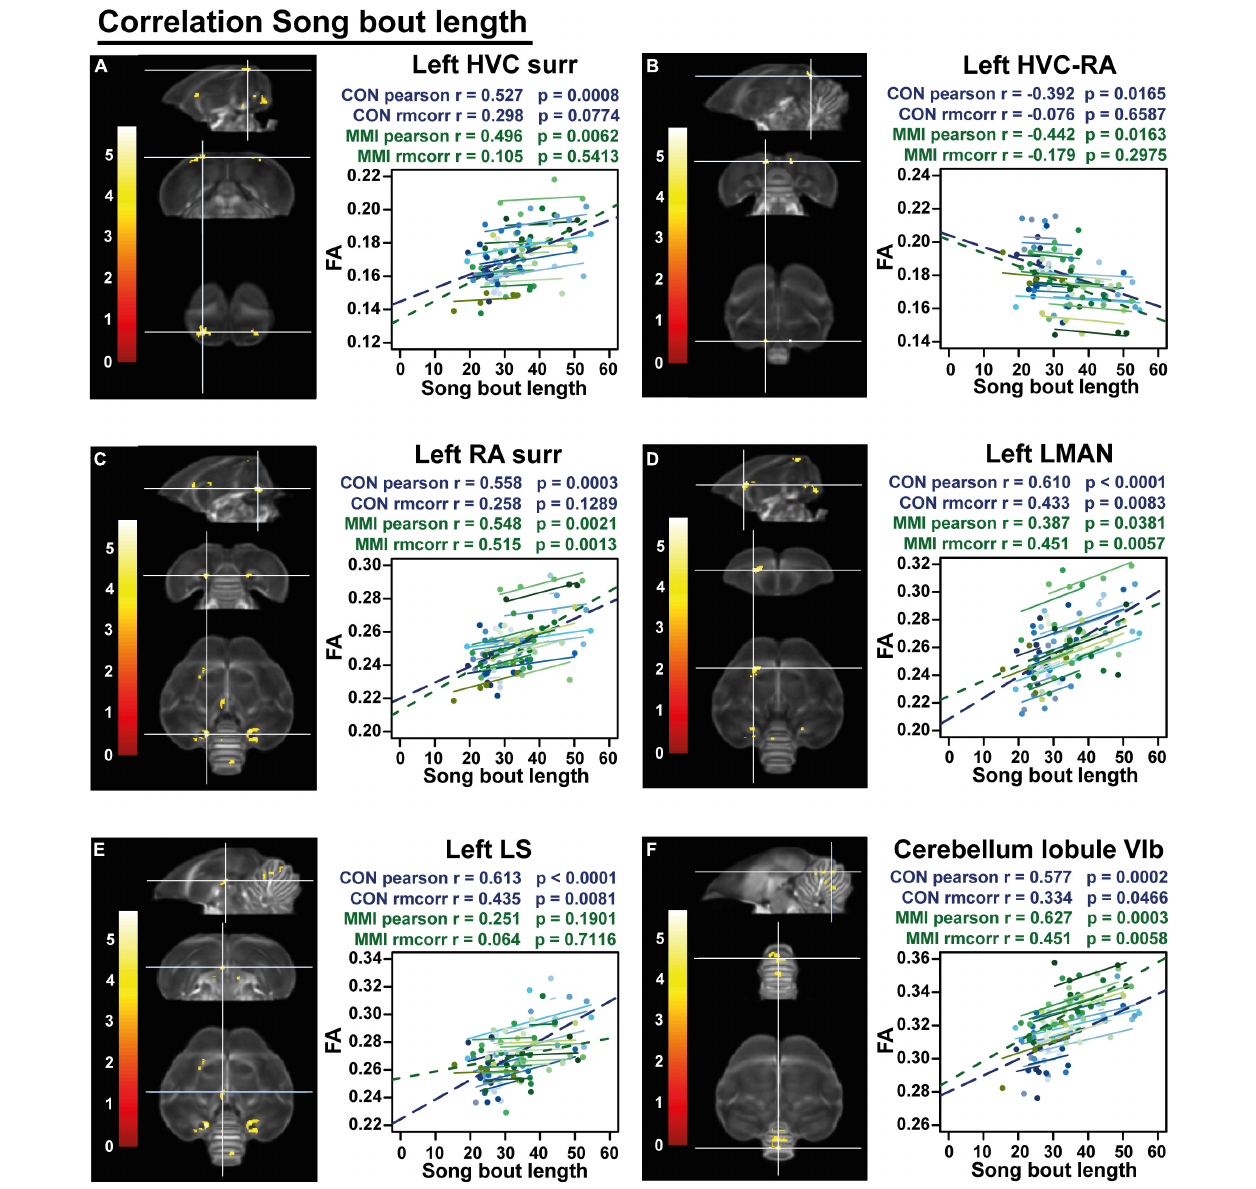
FIGURE 8 | Overview of structural neural correlates of song bout length to fractional anisotropy (FA) in both groups identified using voxel-based multiple regression (A–F) . The statistical maps were assessed at p uncorr < 0.001 and k E ≥ 20 voxels with a small volume correction including regions of the song control system, white matter structures and the cerebellum. Significant voxels are color coded according to their T–values displayed on the scale on the left. Below each statistical parametric map, the identified correlations were further explored with repeated measures correlation of the control group (blue) and MMI treatment group (green). Solid colored lines show the best linear fit for the within-subject correlation in the control group (blue) and MMI group (green) using parallel regression lines with different shades for individual animals. The blue and green dashed line represent the linear fit of the overall Pearson correlation representing the between-subject correlations of the control and MMI group respectively. For bilateral correlations, only the left side is shown. surr,